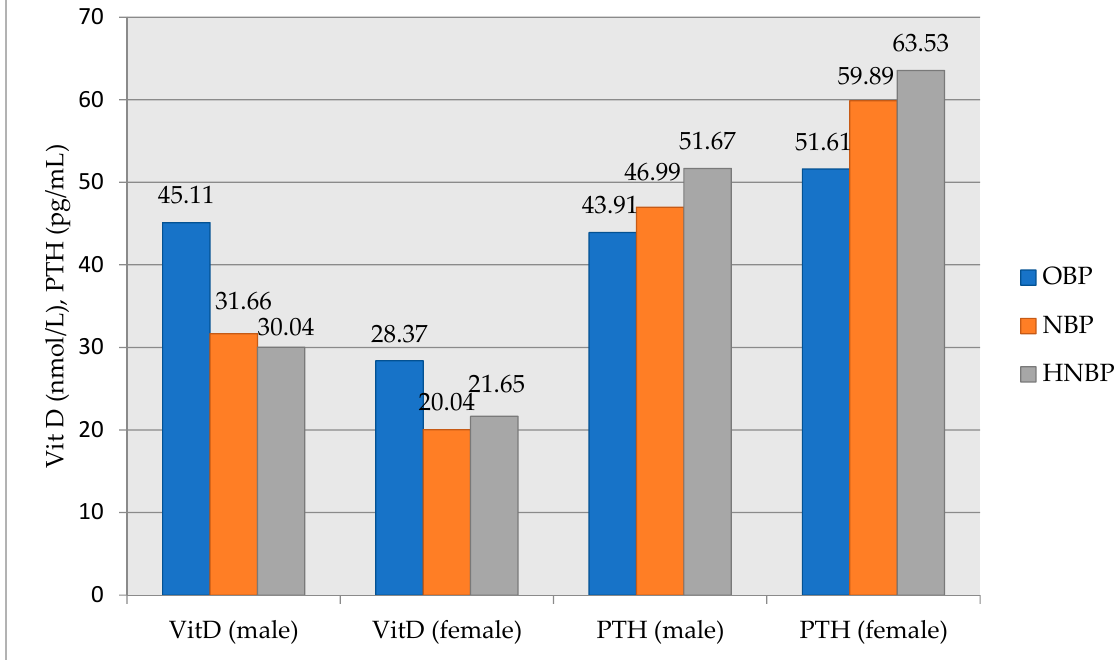
Figure 4. Comparison of vitamin D and PTH levels between subgroups (OBP, NBP, and HNBP) by gender. OBP, optimal blood pressure; NBP, normal blood pressure; HNBP, high-normal blood pressure; VitD, vitamin D; PTH, parathyroid hormone. Table 1. Comparison of anthropometric, blood pressure, and metabolic parameters between NOBP and OBP groups.